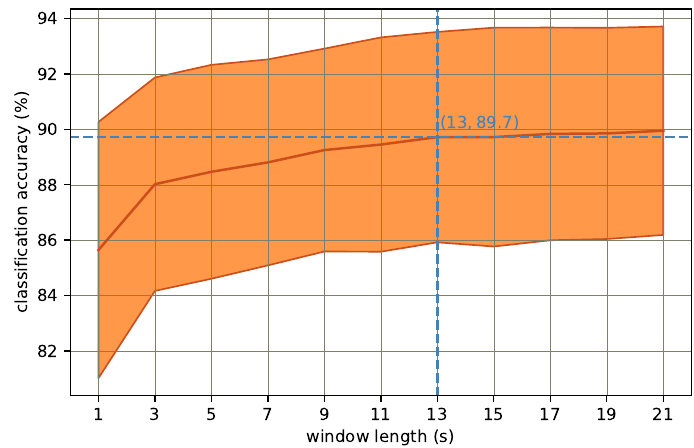
Figure 1. Classification accuracy versus window length in seconds. The shaded areas highlight ± one standard deviation from the mean value.